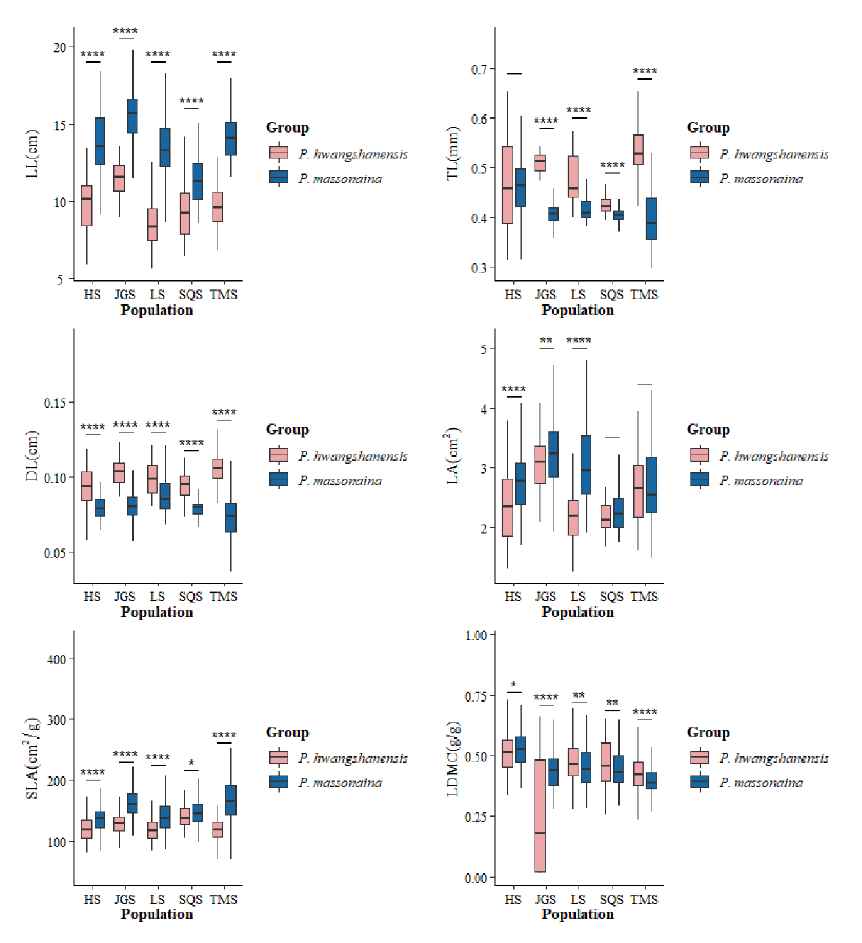
Figure 2. Boxplots of the needle traits in each population between two pine species. The population abbreviations are the same as in Table 1. The three upper, middle, and lower lines represent the 75th, 50th, and 25th percentile values of the variables, respectively. * Significant differences ( p < 0.05) exist in the populations between P. massoniana and P. hwangshanensis (** p < 0.01, **** p < 0.0001). Abbreviations: SQS, Mt. Sanqingshan; LS, Mt. Lushan; JGS, Mt. Jinggangshan; HS, Mt. Huangshan; TMS, Mt. Tianmushan.